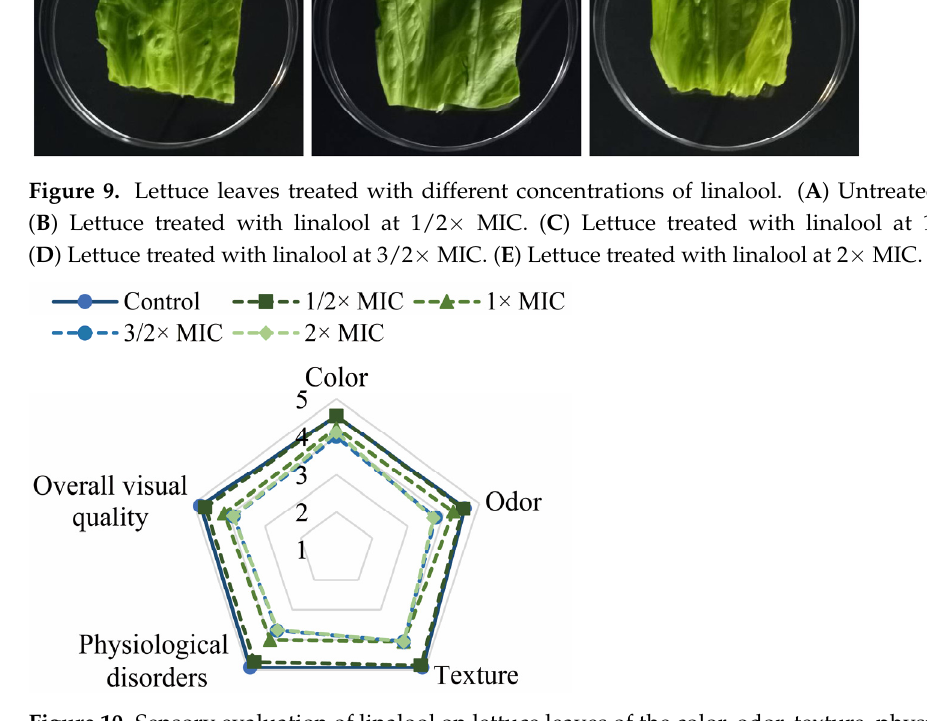
Figure 10. Sensory evaluation of linalool on lettuce leaves of the color, odor, texture, physiological disorders, and overall visual quality.